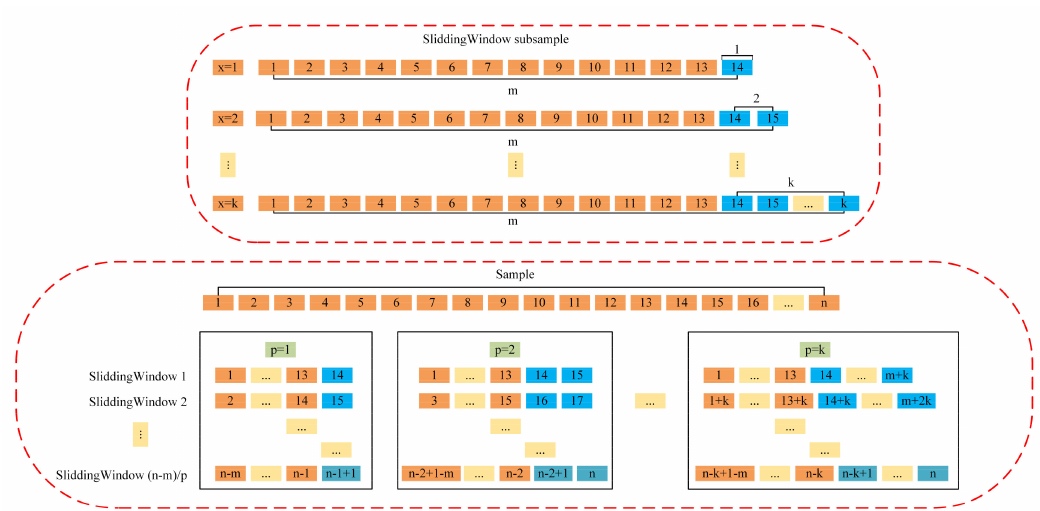
Figure 4. Schematic diagram of sample making process.